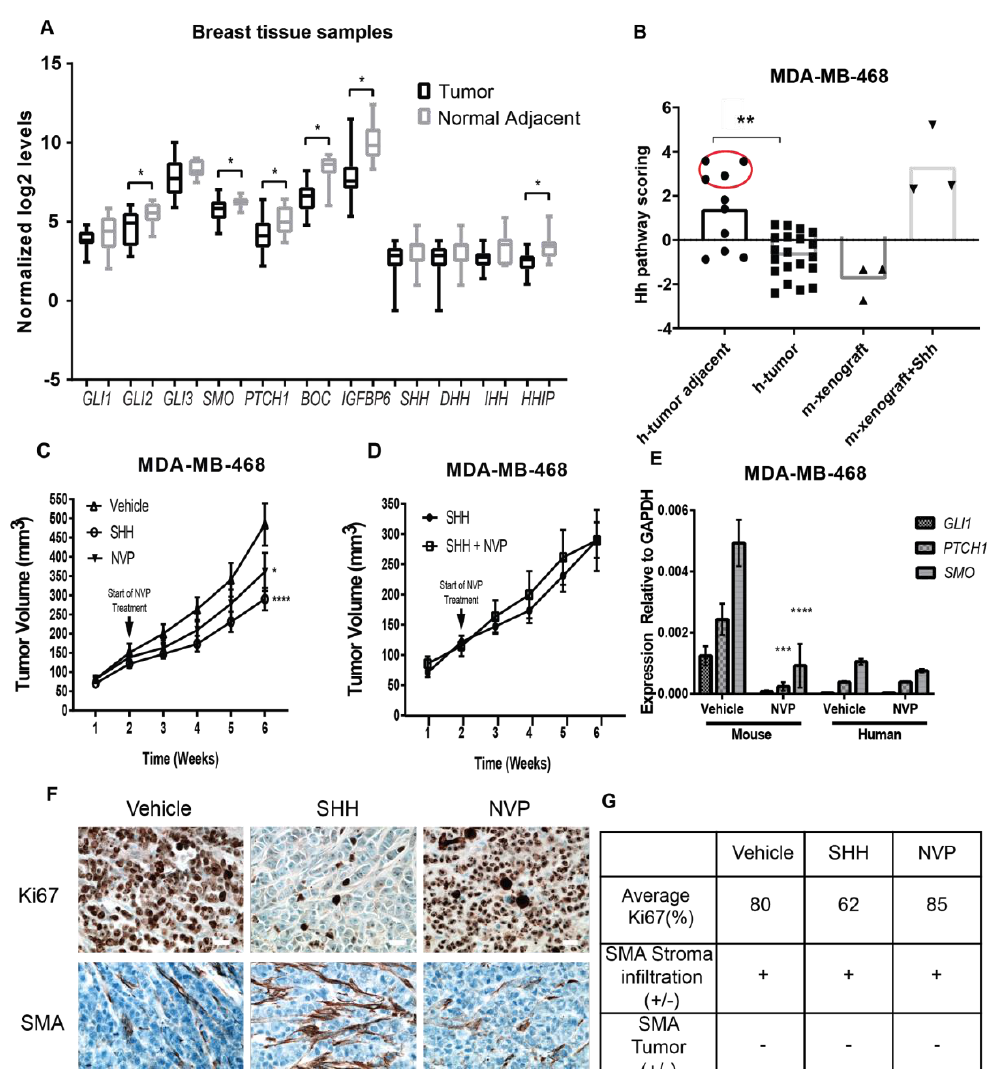
Figure 2. Hedgehog (Hh) signaling in breast tumor tissues and a mouse xenograft model of triple negative breast cancer (TNBC). ( A ) Hh pathway scores for a total of 20 tumors and 10 paired “normal-adjacent tissue” from fresh tumor samples from breast cancer patients in Puerto Rico (PR) were evaluated using the PanCancer pathways array from Nanostring. MDA-MB-468 xenograft tumors +/− Sonic hedgehog (SHH)-ligand collected at two weeks post-injection were used as negative and positive controls for SHH-signaling. TNBC samples are highlighted in red. Adjusted ** p -value < 0.005. ( B ) The normalized log2 expression for Hedgehog-pathway genes across tumor and normal adjacent breast tissue samples are shown in ( A ). Significance determined by Student t -test * p -value < 0.05. ( C,D ) Tumor growth curves in xenograft tumors composed by MDA-MB-468 +/− SHH-ligand. NVP or Vehicle was administered daily during the last four weeks. Data shows mean +/− standard error of mean (SEM) of nine mice per group. Significance was determined via ANOVA analysis. * p -value < 0.05, **** p -value < 0.0001. ( E ) Expression levels of glioma associated oncogene family zinc finger 1 ( GLI1 ) and patched1 ( PTCH1 ) transcripts relative to Glyceraldehyde-3-Phosphate Dehydrogenase (GAPDH) in xenografts tumors and NIH3T3 cells using human and mouse-specific primers. Data shows mean +/− SEM of six mice per condition. Significance was determined via ANOVA analysis, Adjusted *** p -value < 0.001 and **** p -value < 0.0001. ( F ) Representative immunohistochemistry staining from mouse tumor xenografts treated with Vehicle, NVP, and SHH-ligand. Scale bar = 20 µ m. ( G ) Average values of Ki67 and SMA staining for two tumors of each experimental treatment were summarized based on the reported values in the pathology